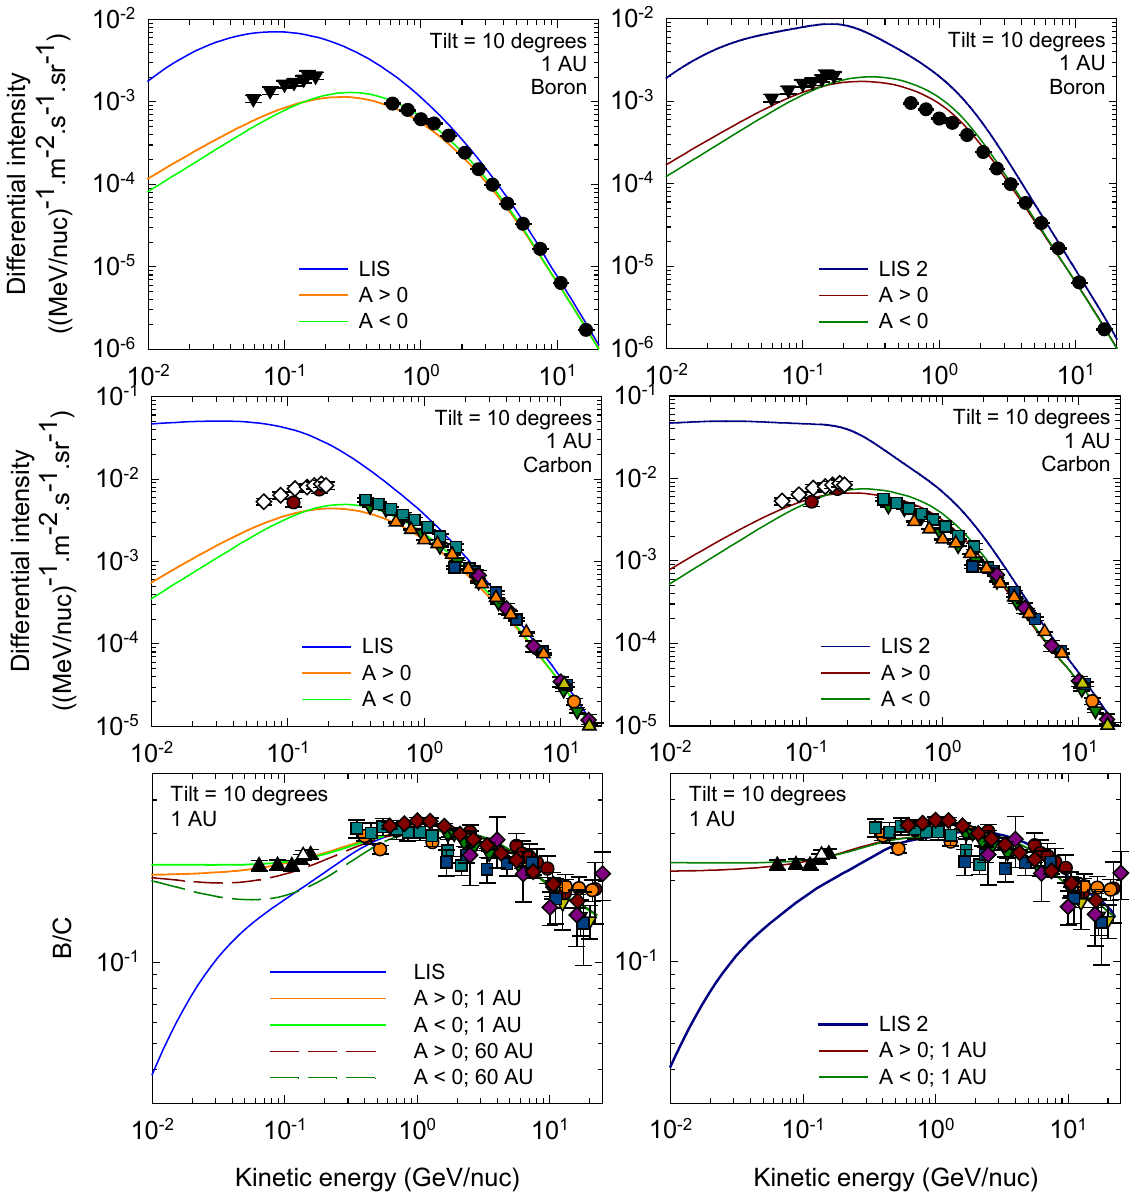
Fig. 6. Top and middle panels: Computed differential intensities for B (top) and C (middle) at Earth for both polarity cycles compared to B observations from the HEAO-3 experiment (Engelmann et al., 1990) and ACE (Davis et al., 2000) and C observations (see Stephens and Streitmatter, 1998 for references), respectively. Computations are done with the IS for B and C by Moskalenko et al. (2002) (left panels) and by Moskalenko et al. (2003) (right panels). Bottom panel: B/C as a function of kinetic energy for both polarity cycles with α =10 ◦ compared to observations. The computations are done with a TS in the model and are compared to the interstellar B/C (at 120AU) as a reference (blue lines). The data compilation is taken from Moskalenko et al. (2003).